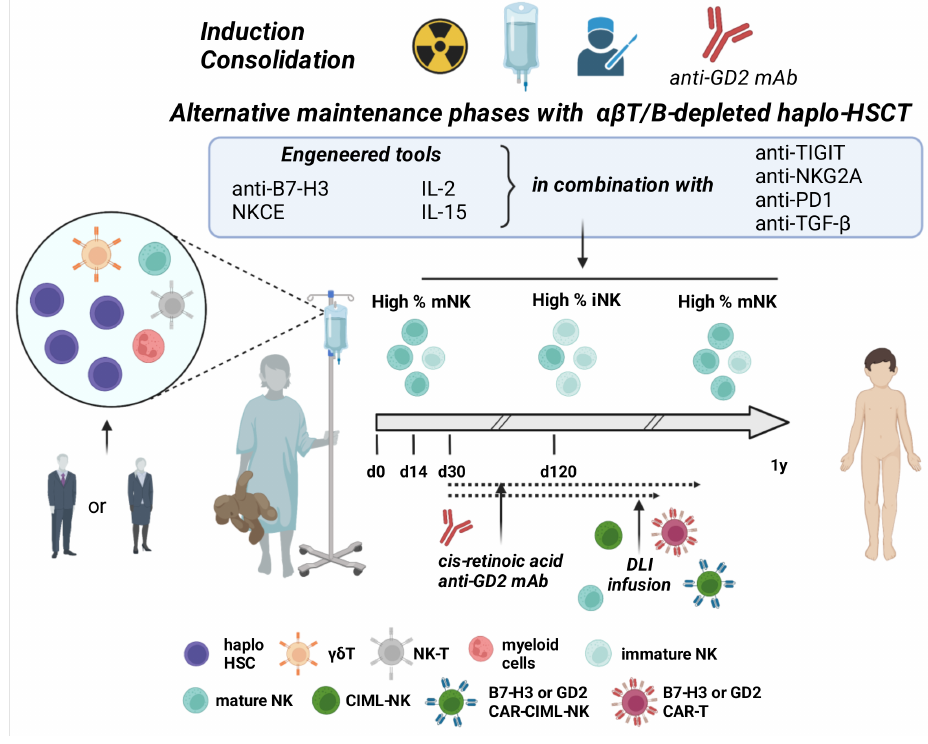
Figure 3. Possible combining strategies to optimize the maintenance phase in HR-NB. A β T/B- depleted haplo-HSCT ensure a high number of mature effectors, including NK cells, in the early phase post-transplant. NK cells could be made more effective also using engineered engagers or cytokines modified to reduce their toxicity, eventually in combination with the inhibitory signal blockade. Immune responses against NB could also be potentiated by the infusion of in vitro activated natural or engineered donor T or NK lymphocytes (DLI). CIML-NK = cytokine induced memory-like NK; NKCE = NK cell engagers; CAR = Chimeric antigen receptor. Created with